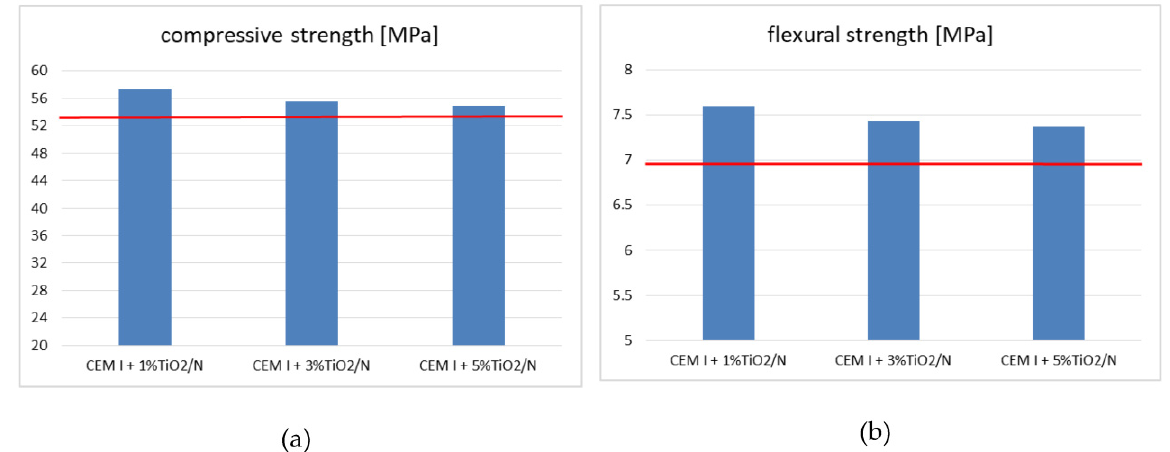
Figure 4. ( a ) Compressive and ( b ) flexural strength of cement mortar with the addition of 1, 3, and 5 wt.% of photocatalyst TiO 2 /N. In the red line, the compressive strength (53 MPa) and flexural strength (6.92 MPa) of control sample are presented [23].